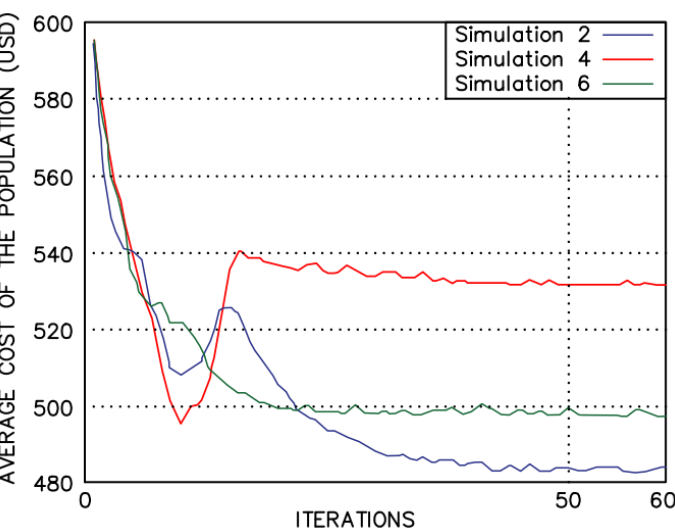
Figure 5. Variation in the average value of the Fitness Function at each iteration of Simulations 2-1, 4-1, and 6-1.